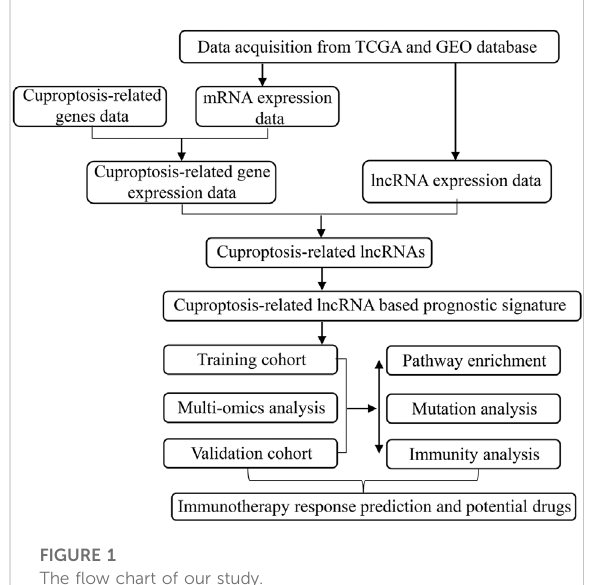
FIGURE 1 The fl ow chart of our